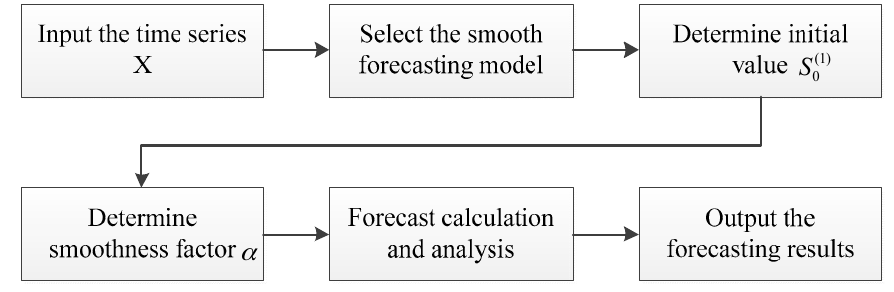
Figure 4. Flow chart of the SES model.